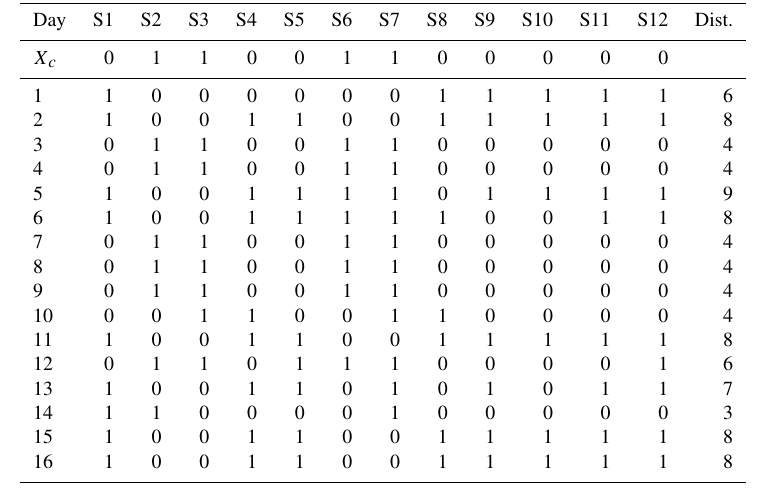
Table Appendix A2. Example dataset for estimating distances. The second row presents the current daily precipitation occurrences for 12 stations and the rows below show the absolute difference between the current occurrences ( X c ) and the observed data in Table A1. The last column presents the distances in Eq. (11).